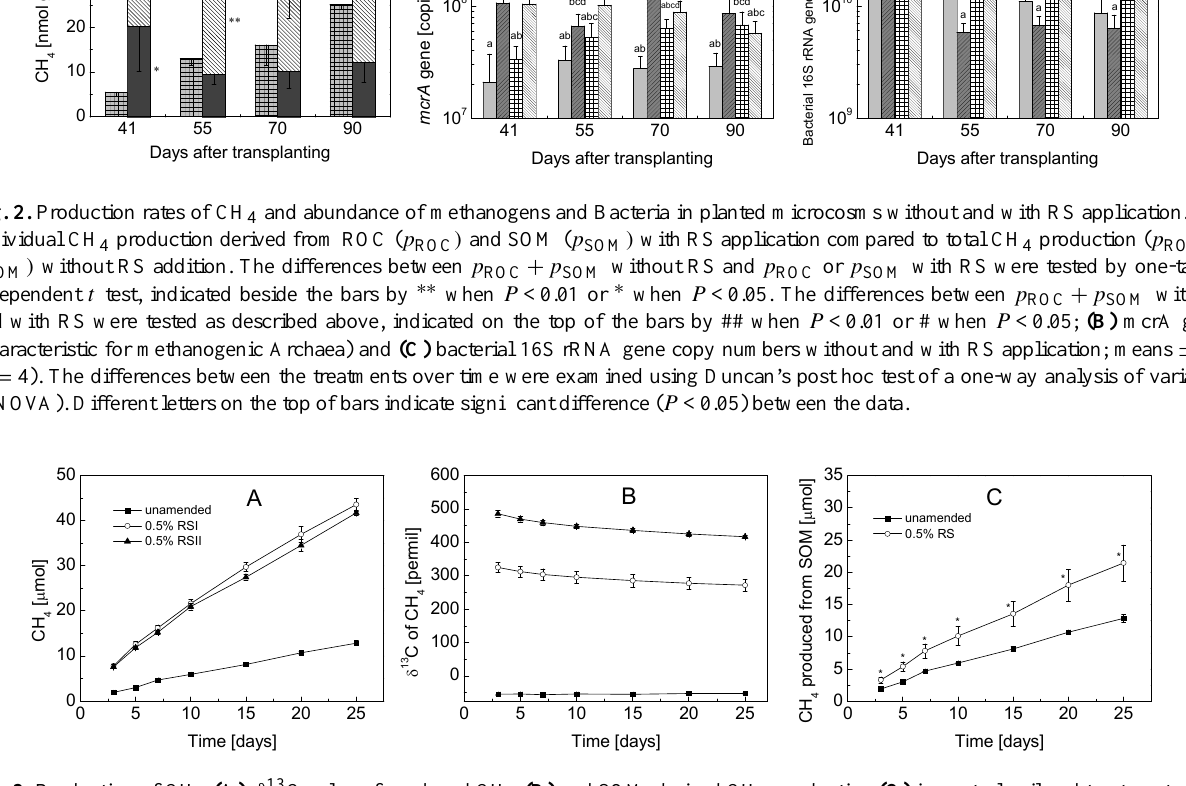
Fig. 3. Production of CH 4 (A) , δ 13 C value of produced CH 4 (B) and SOM-derived CH 4 production (C) in control soil and treatments with 0.5% 13 C-labeled RS I or II after 40days of anoxic pre-incubation. The RS was applied at the beginning of anoxic incubation. The headspace of all bottles was re-flushed with N 2 after 40days of anoxic incubation. Therefore, “day 0” on the x axis corresponds to the actual date of “day 40” in the entire incubation period. Data are means ± SD ( n = 3). The differences between control and RS treatment in SOM-derived CH 4 production were tested by two-tailed independent t test, indicated by ∗ when P